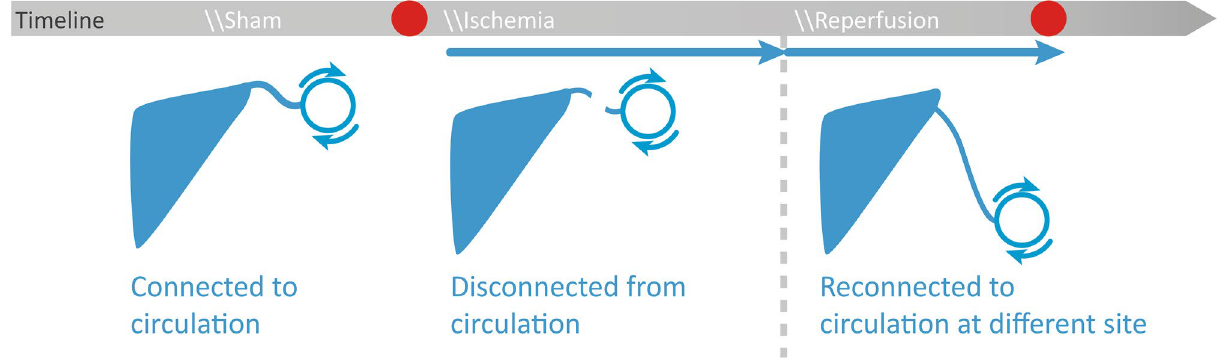
Figure 5. Timeline of specimen harvest during free flap